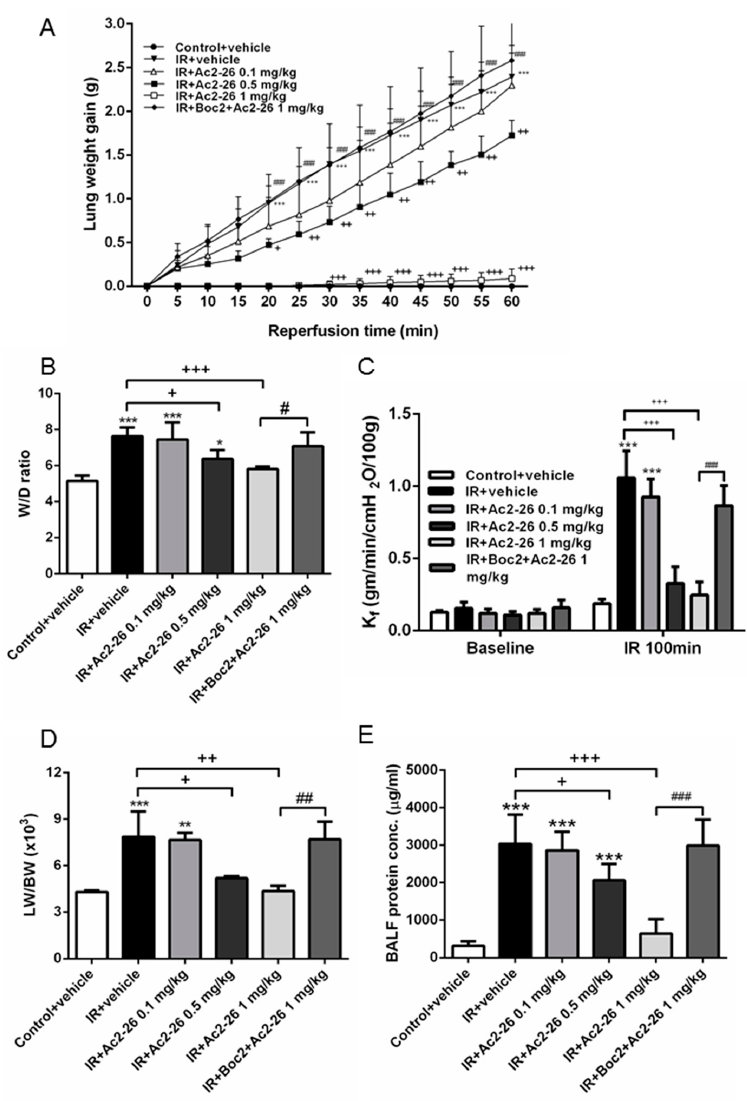
Figure 1. Effect of Ac-AMVSEFLKQAWFIENEEQEYVQTVK (Ac2-26) and N-Boc-Phe-Leu-Phe-Leu-Phe (Boc2) on pulmonary edema. Lung weight gain ( A ); wet/dry (W/D) weight ratio ( B ); vascular filtration coefficient (K f ) ( C ); lung weight/body weight (LW/BW) ( D ); and protein concentration in bronchoalveolar lavage fluid (BALF) ( E ) increased significantly in the ischemia-reperfusion (IR) group. The increase in these parameters was significantly attenuated by treatment with Ac2-26. The protective effect of Ac2-26 was abrogated by the addition of Boc2. Data are expressed as means ± standard deviation (SD) ( n = 6 per group). * p < 0.05, ** p < 0.01, *** p < 0.001, compared with the control group; + p < 0.05, ++ p < 0.01, +++ p < 0.001, compared with the IR group; # p < 0.05, ## p < 0.01, ### p < 0.001, compared with the IR + AC2-26 1 mg/kg group.